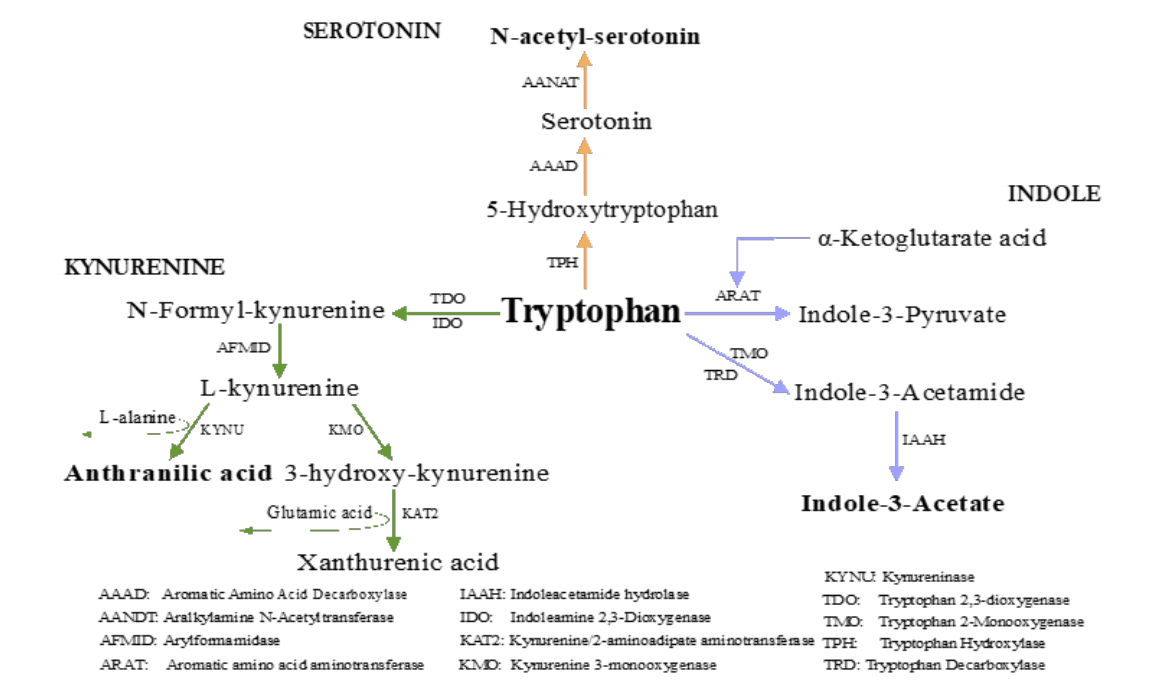
Figure 1. Schematic representation of the identified metabolites separated by the three major trypto- phan pathways. The metabolites changed three months after RYGB are highlighted in bold. Statistical significance p < 0.05.